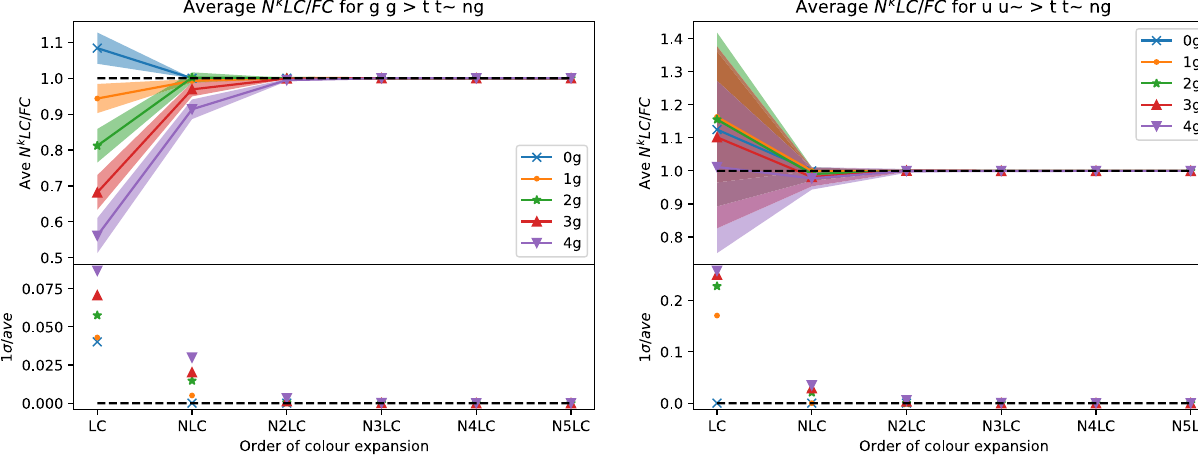
Fig. 6 Same as Fig. 3 but for the processes gg → t ¯ t + ng and u ¯ u → t ¯ t +